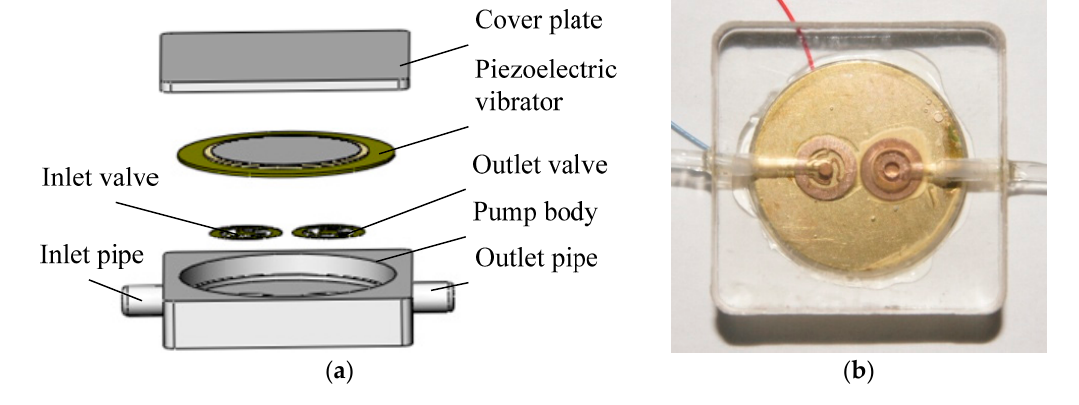
Figure 1. Micro-pump for experiment. ( a ) Micro-pump structure; ( b ) Micro-pump used in the experiment.